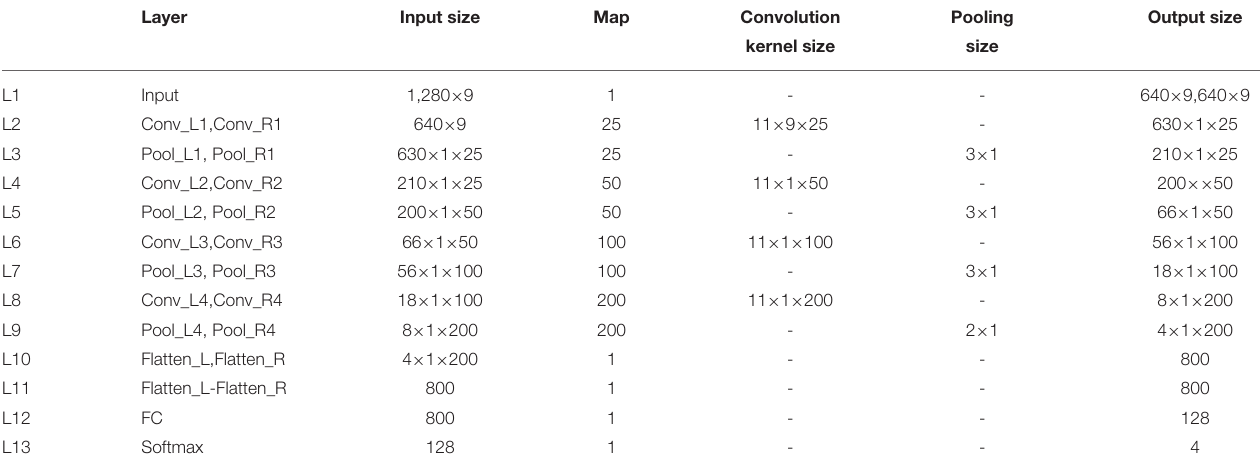
TABLE 1 | Proposed CNN